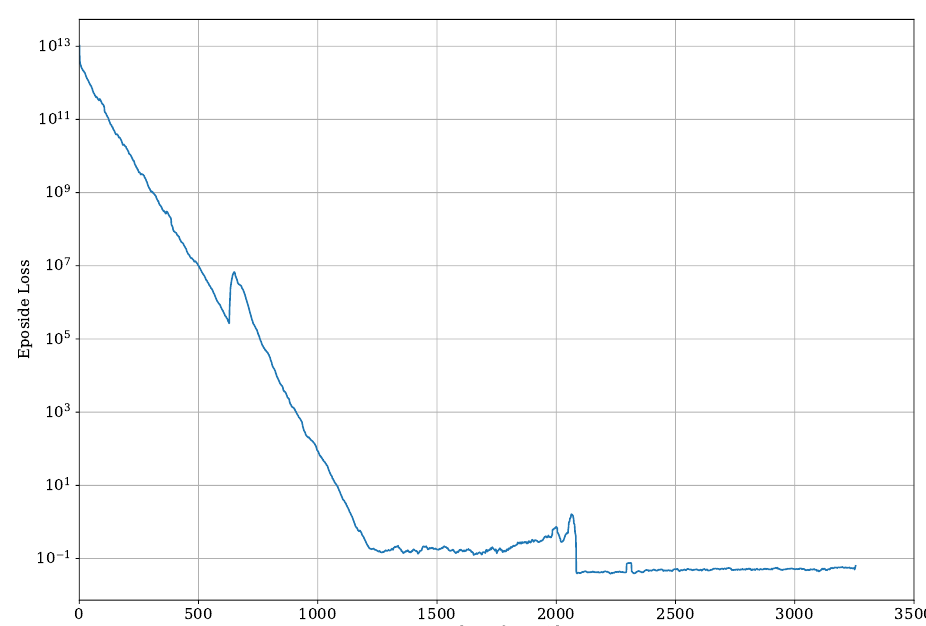
Figure 8. Training: (cid:101) -greedy policy of DQN model.